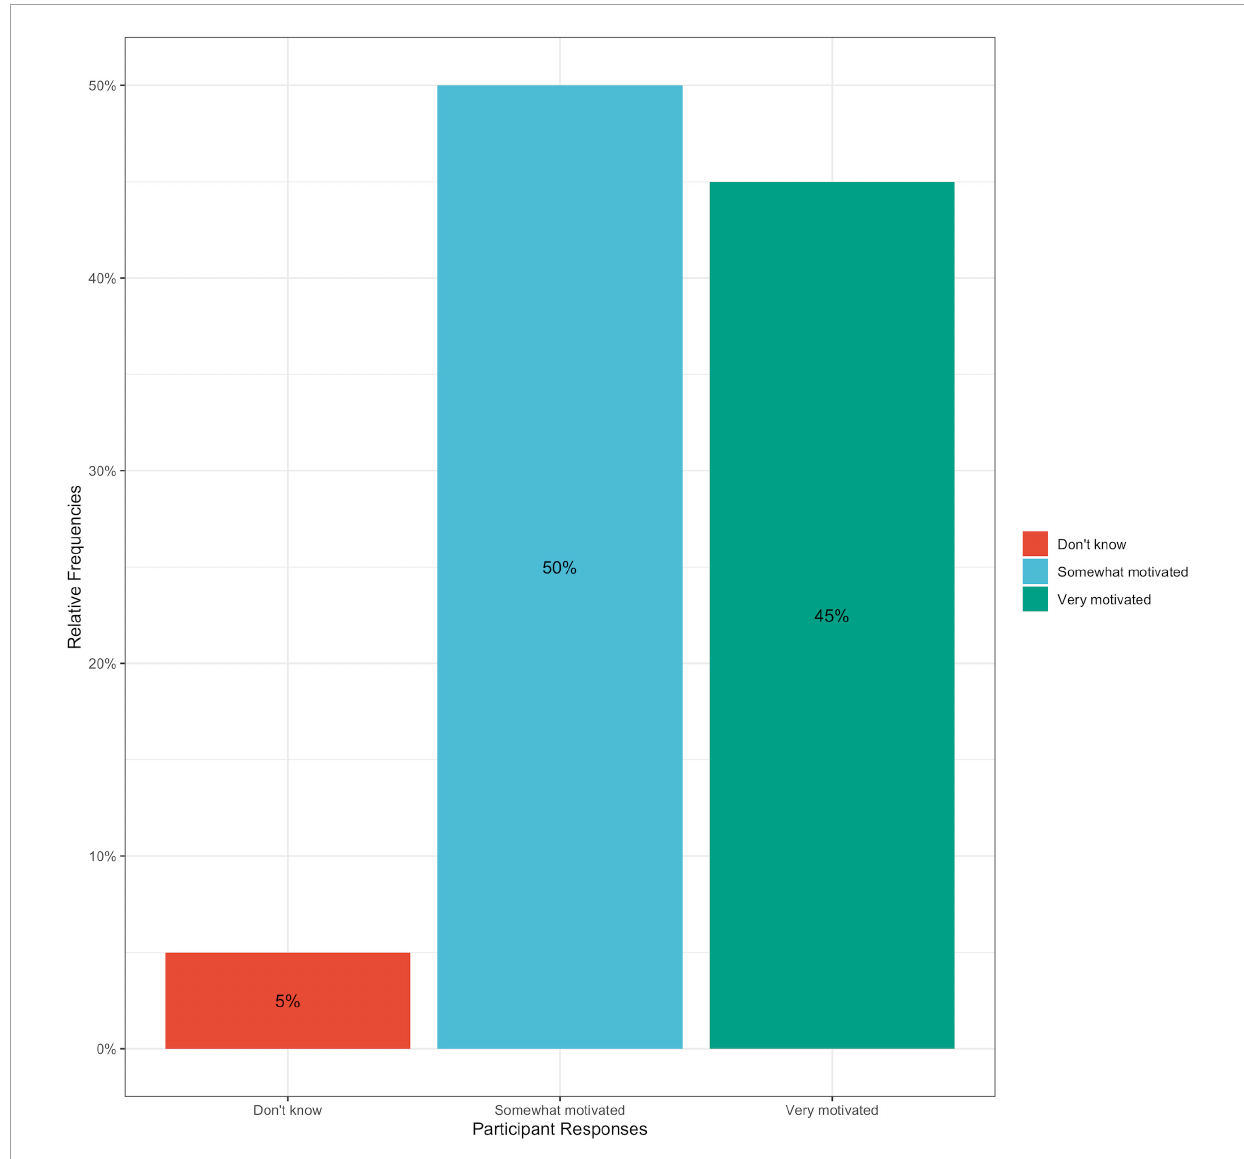
FIGURE6 Bar graph of percentage of participant responses to post-intervention survey question: How motivated would you say you have felt during the past 3 weeks to achieve dietary change? Answer choices included: Very motivated, somewhat motivated, neither, somewhat unmotivated, and very